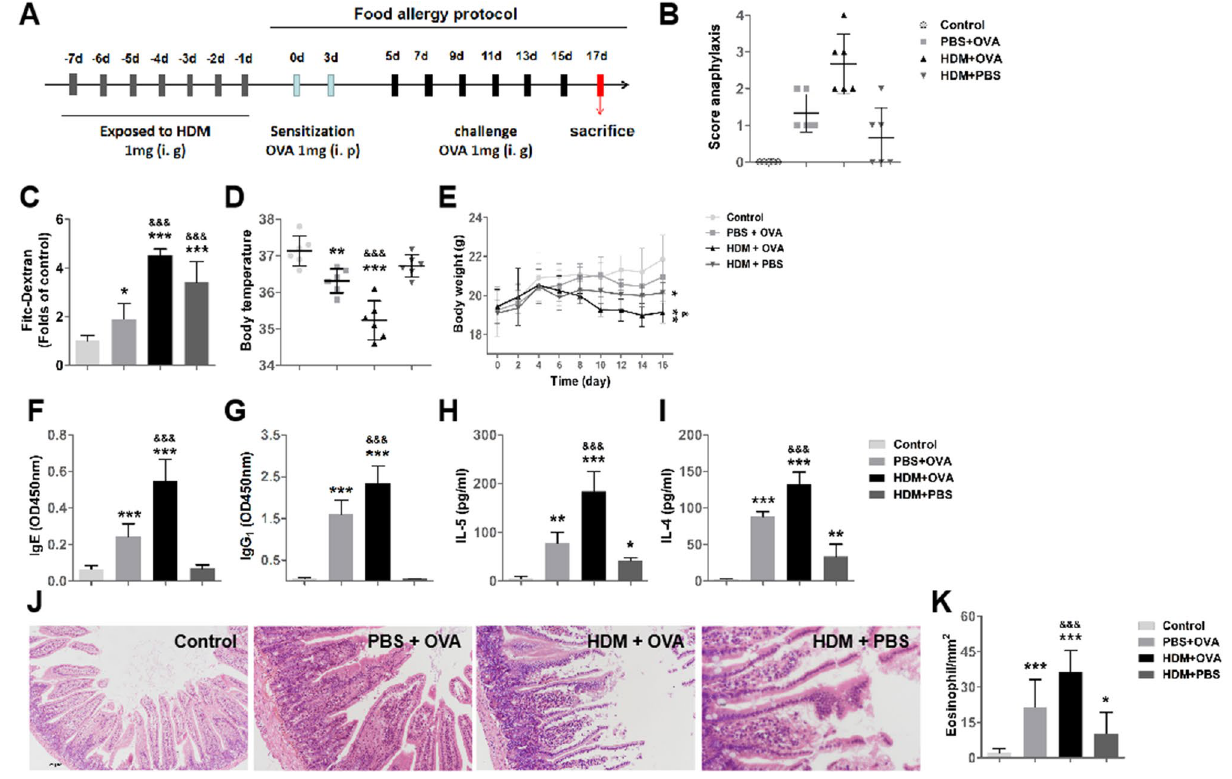
Figure 4. Exposure to HDM facilitates development of OVA-induced intestinal allergy. ( A ) The protocol for mouse model of HDM facilitates OVA-induce food allergy. ( B ) the score of allergies of mouse. no symptoms, 0; scratch, scratch head and nose, 1; eye and mouth swelling, diarrhea, reduced activity and/or reduced activity with breathing emergency urge, 2; asthma, slow breathing, mouth and tail cyanosis, 3; After stimulating or shaking, there is no activity, 4; death, 5. ( C ) Permeability to dextran (4,000-Da) of intestinal epithelial barrier in vivo. ( D ) the body temperature of mouse. ( E ) body weight of mouse. ( F – G ) The bars show the levels of serum OVA specific IgE and IgG1. ( H – I ) The bars show the levels of IL-4 and IL-5 in the splenocyte culture supernatant. ( J ) HE staining of jejunum. ( K ) the number of eosinophils in the jejunum. Each group consists of 6 mice. * p < 0.05, ** p < 0.01, *** p < 0.001, (ANOVA) compared to the control group. & p < 0.05, && p < 0.01, &&& p < 0.01 ( t test) was compared to the PBS + OVA